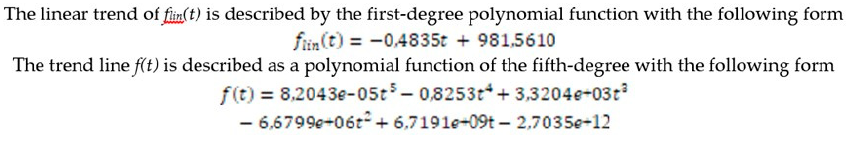
Figure 8. Trends of changes in the frequency of minor accidents in civil engineering over time.